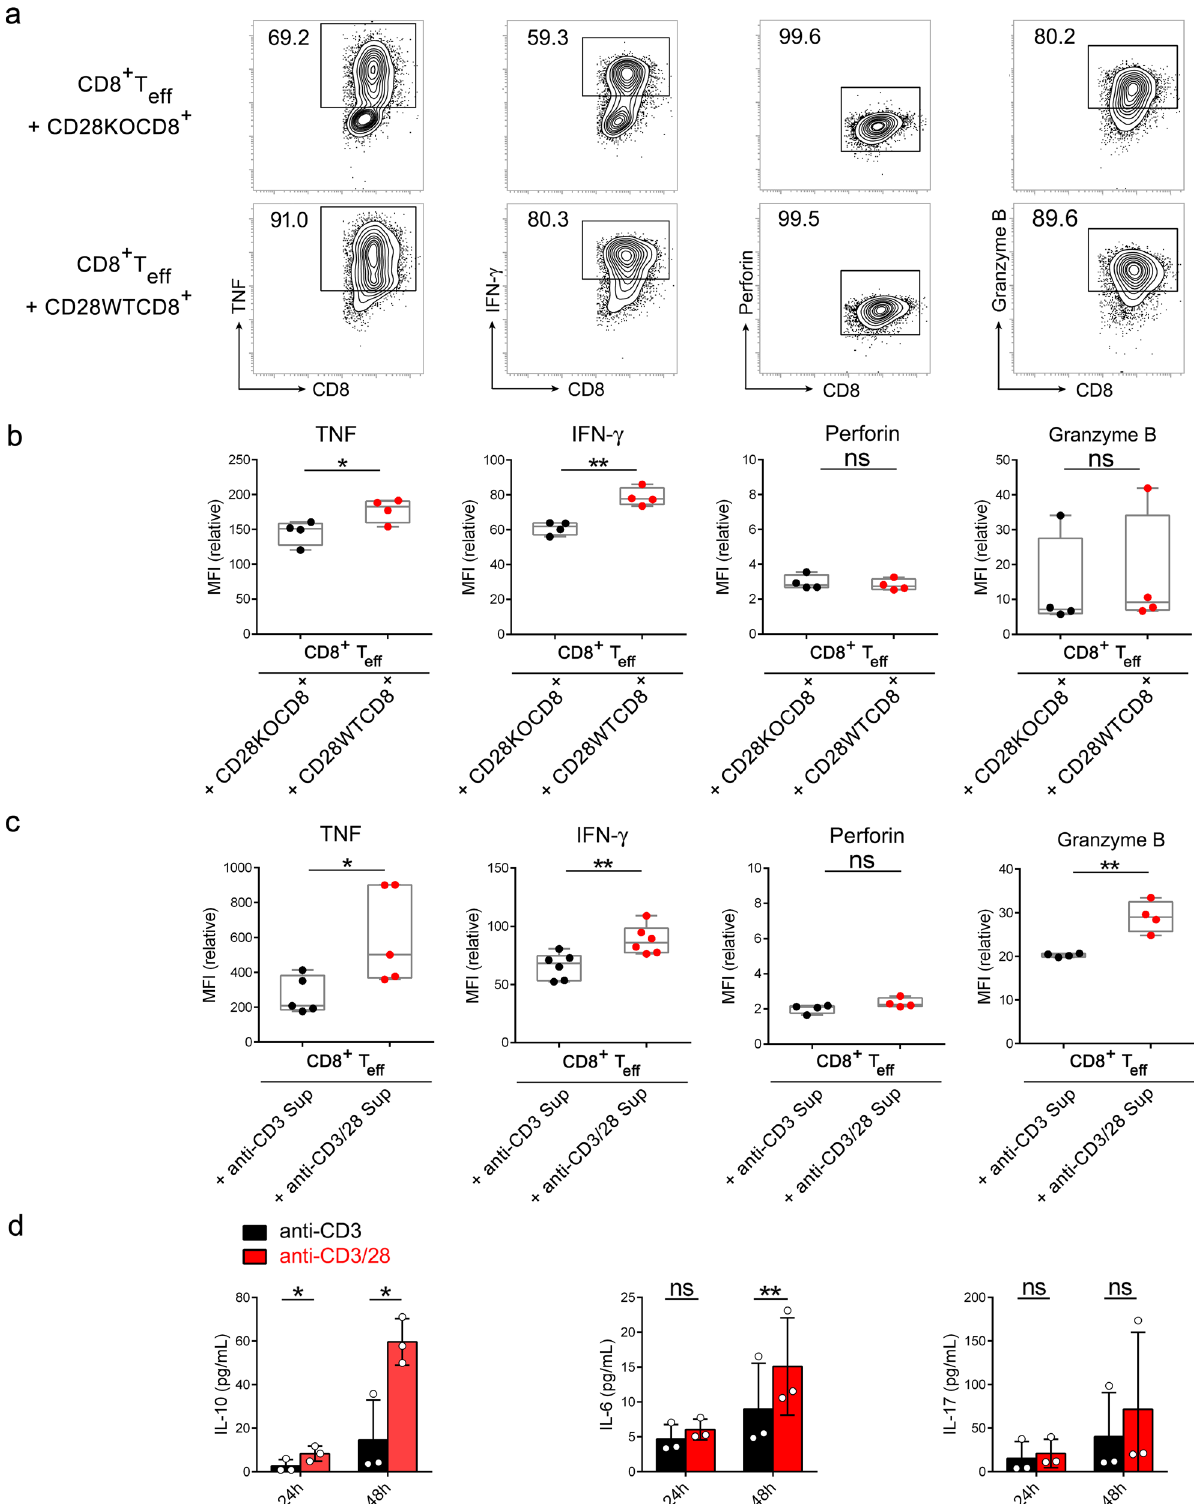
with anti-CD3 antibody (13.70 ± 1.149 μ M) than in cultures stimulated with anti-CD3/CD28 antibodies (6.27 ± 0.716 μ M), and CD73 inhibitor almost completely inhibited AMP conversion to adenosine (Fig. 4j and Supplementary Fig. 2d). The levels of residual AMP 13C,15N in anti-CD3-stimulated (23.51 ± 1.232 μ M, conversion rate 37.3%) and anti-CD3/CD28-stimulated (28.79 ± 1.277 μ M, conversion rate 23.4%) cultures indicate that